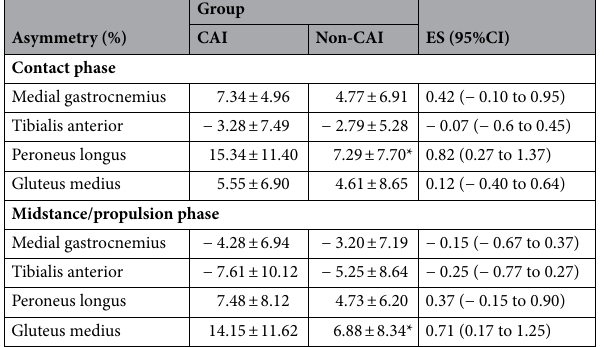
Table 3. Mean ± SD, effect size (ES) and 95% confidence interval (CI) for muscle activity asymmetry between CAI and Non-CAI groups. CAI Chronic ankle instability, ES (95%CI) effect size (95% confidence interval), *Indicates a significant difference from the CAI group (P ≤ 0.010).